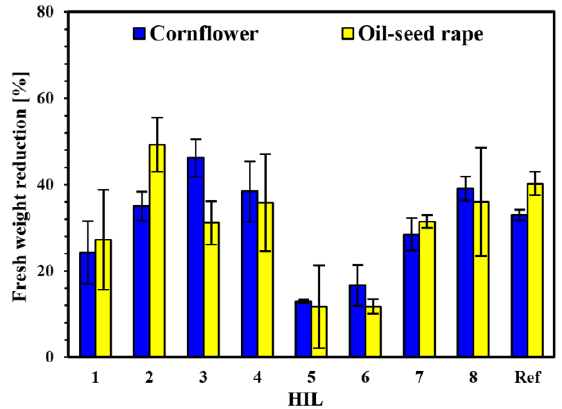
Figure 5. Herbicidal activity of the synthesized HILs ( 1 – 8 ) compared to commercial preparation Huzar 05 WG (Ref) toward cornflower and oil-seed rape.